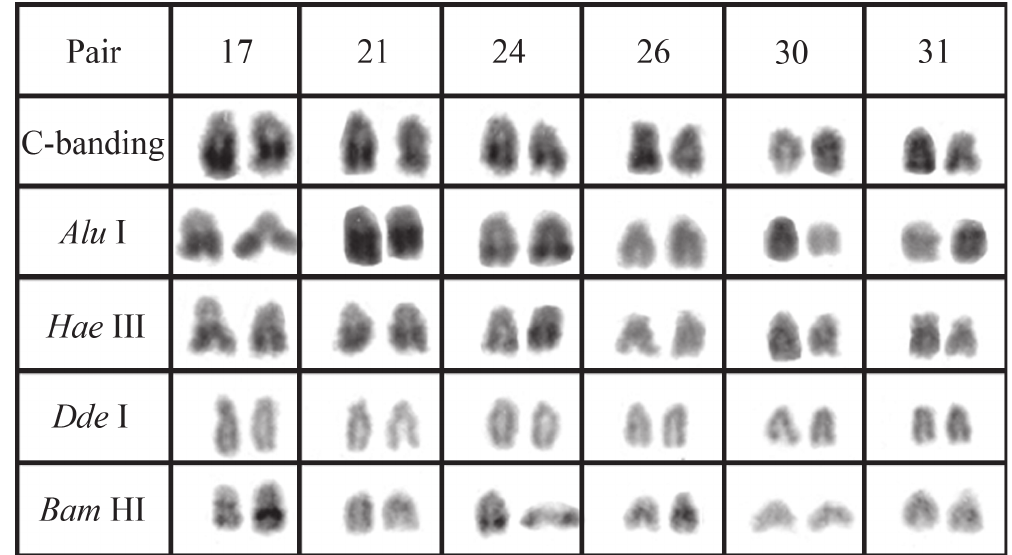
Fig. 3. Chromosomal pairs of Hypostomus cf. wuchereri from Una River showing the C-bands and the digestion profiles using Alu I, Hae III, Dde I, and Bam